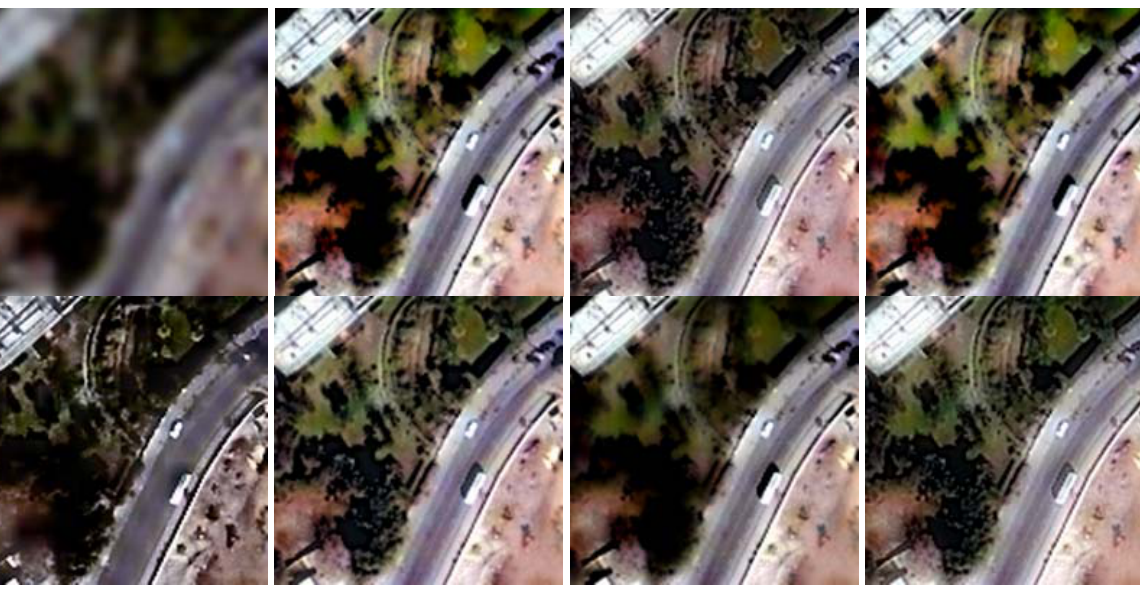
Figure 5. Subscenes of the original LRMIs and the HRMIs produced by different methods. (Left to right sequence) Original LRMIs, IHS, AWT, BT, DWT, HPF, HPM, and the proposed